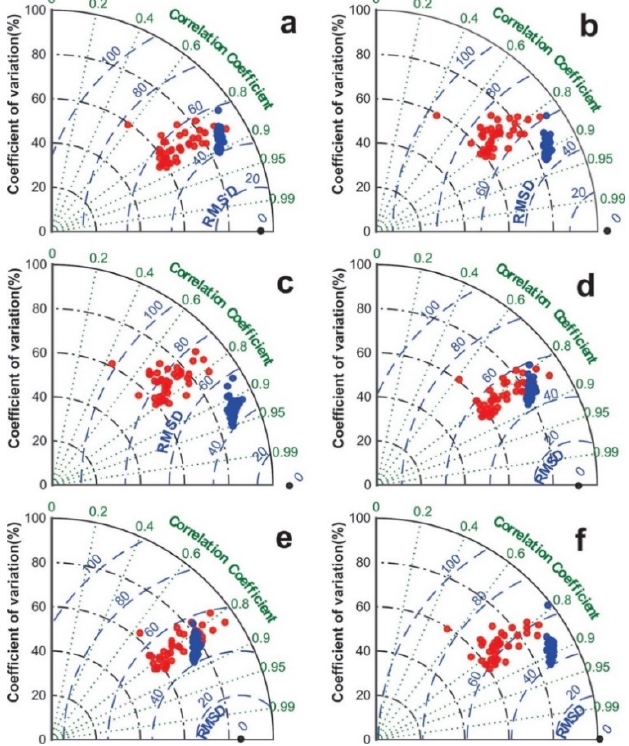
Figure 3. Taylor diagrams displaying a statistical comparison for precipitation datasets (coefficient of variation (%), the root mean square deviation RMSD (%) and the correlation coefficient) between climate models with bias correction and climate models without bias correction (blue and red dots, respectively) for six basins controlled at the following stations: ( a ) Ramis, ( b ) Unocolla, ( c ) Ilave (located in Peru), and ( d ) Chuquiña, ( e ) Calacoto Maure, ( f ) Calacoto Desaguadero (located in Bolivia), for the 1984–2014 period.